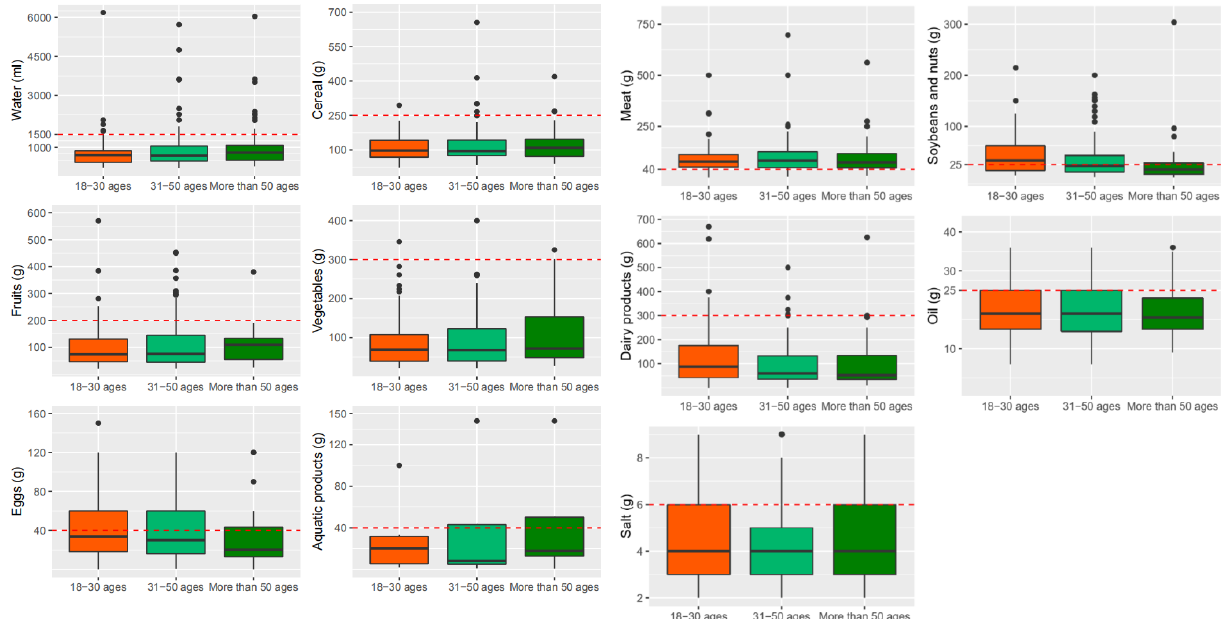
Figure 5. Dietary intakes of Tibetan local residents in different age groups.